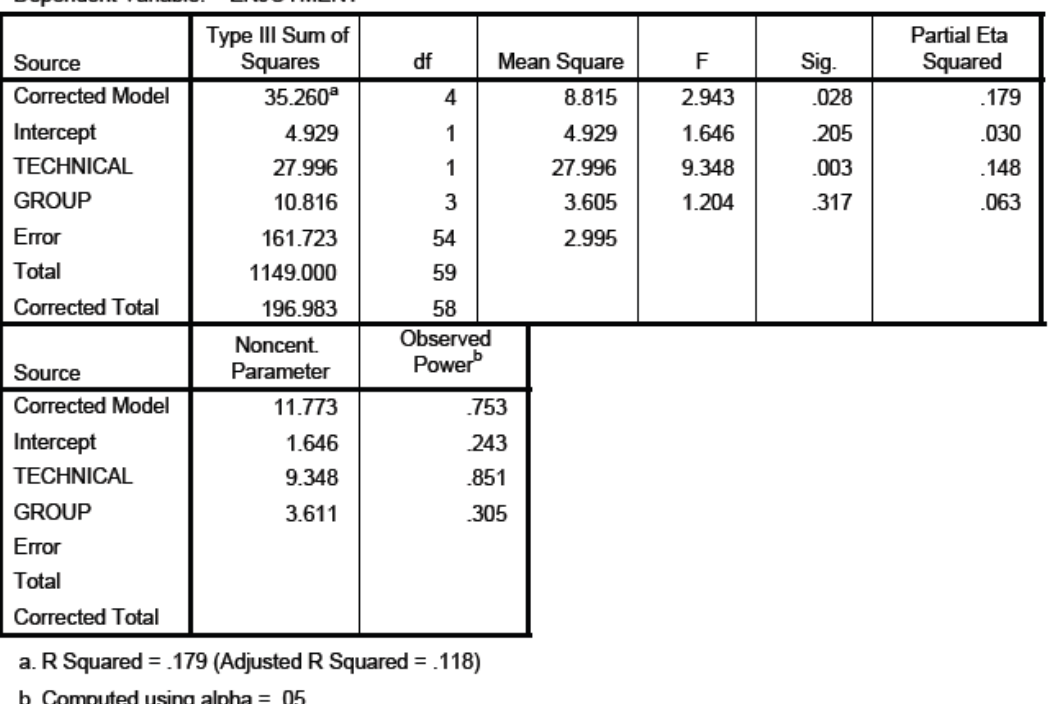
Figure B.16. ANCOVA analysing enjoyment levels between the four groups of participants using data adjusted for technical performance for participants who correctly indicated their